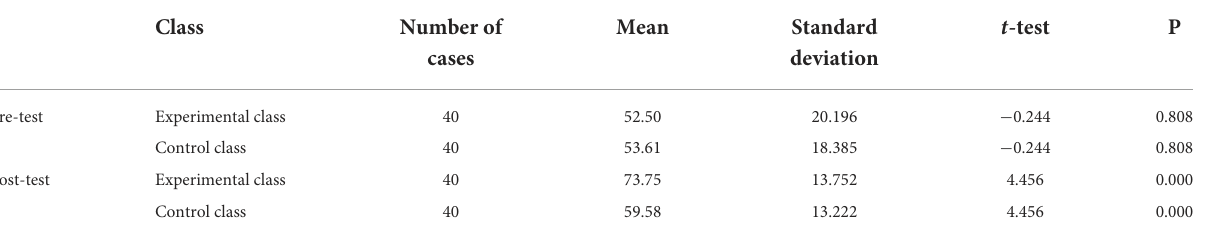
TABLE 2 Statistical analysis of students’ pre-test and post-test